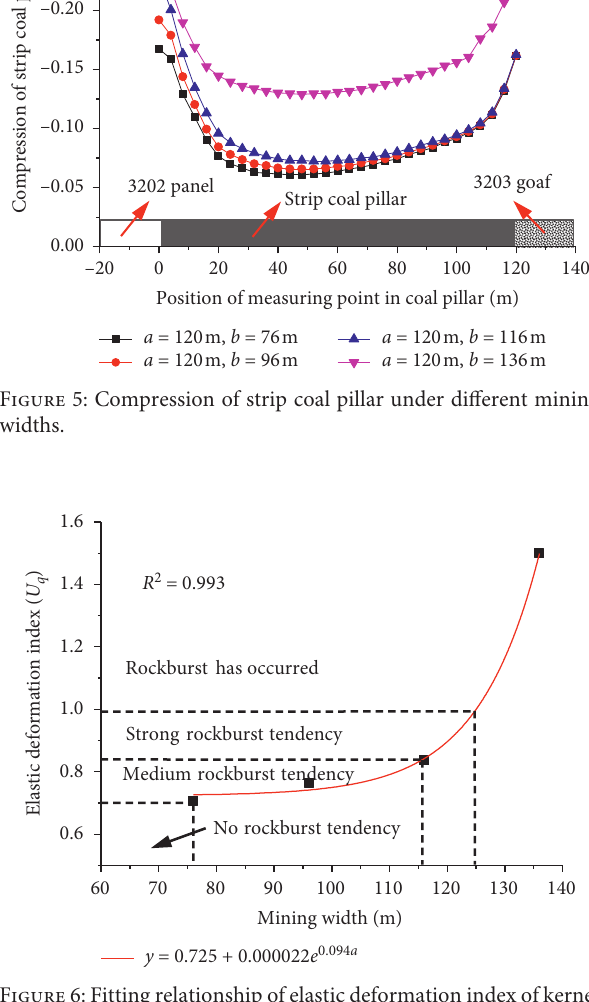
Figure 8: Fitting relationship of U q and the width of the coal